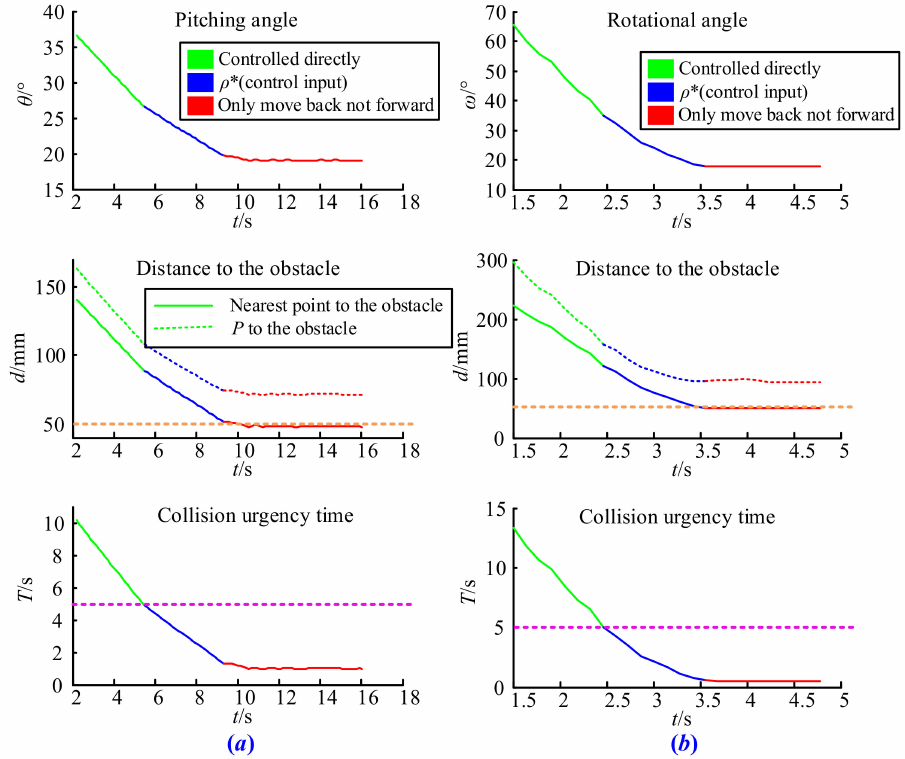
Figure 13. Result of the special case test: ( a ) special pitching cases, ( b ) special rotating